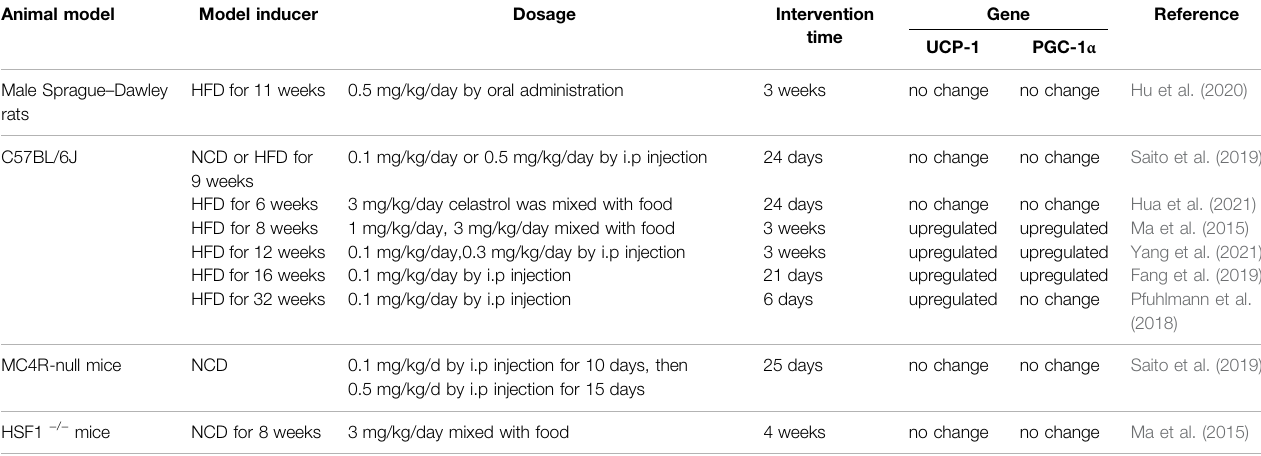
TABLE 2 | The regulation of celastrol on iWAT browning and BAT thermogenesis gene. Animal model Model inducer